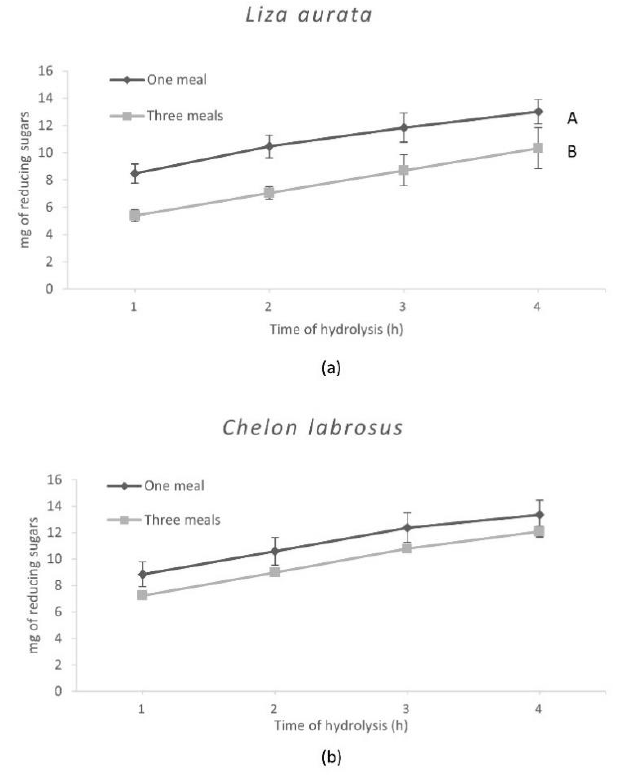
Figure 3. Release of reducing sugars from L. aurata ( a ) and C. labrosus ( b ) when the different feeding frequencies in vitro (n = 18). Data expressed as means ± SD. Significant differences between feeding patterns ( p < 0.05) are indicated using uppercase letters (A, B).